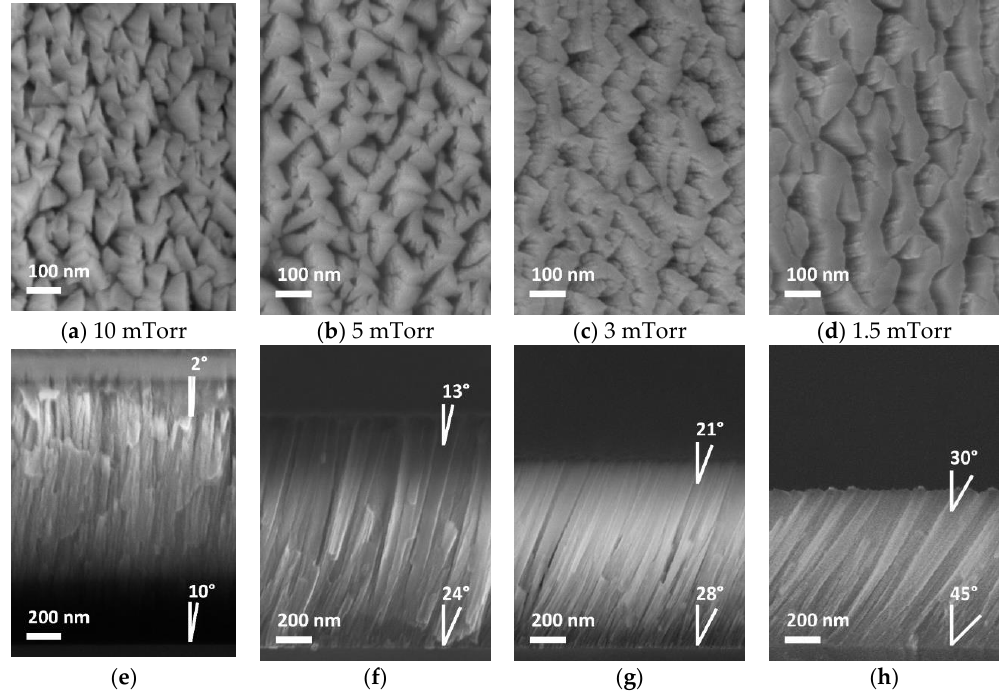
Figure 2. ( a – d ) Top-view and ( e – h ) side-view scanning electron microscope (SEM) images of AlN nanocolumns grown at different working gas pressures. The average β angles measured from side- images ( e – h ) are 38 ◦ , 25 ◦ , 19 ◦ , and 5 ◦ , respectively. Initial and final β values of the nanocolumns